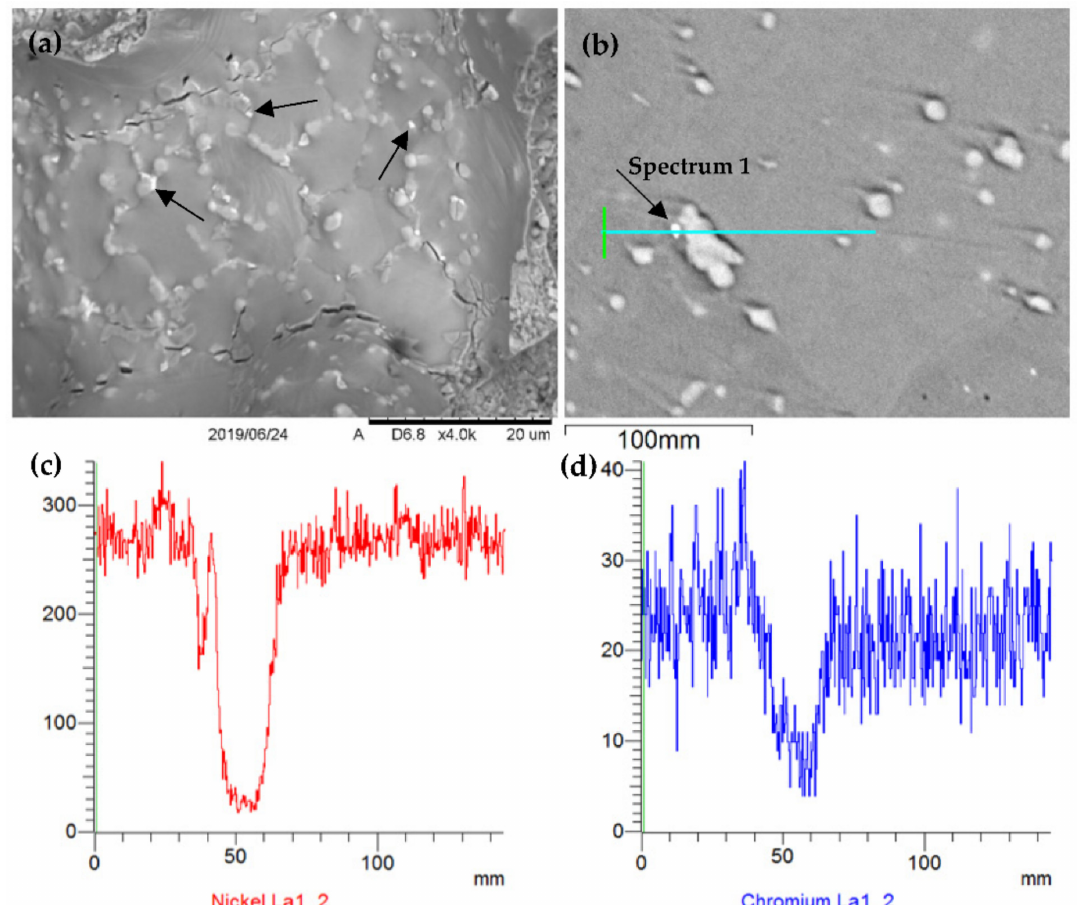
Figure 3. SEM analysis of alloying elements in a composite’s material: ( a ) fracture, Ni 2 Cr -phase is shown by arrows; ( b – d ) EDS linear analysis